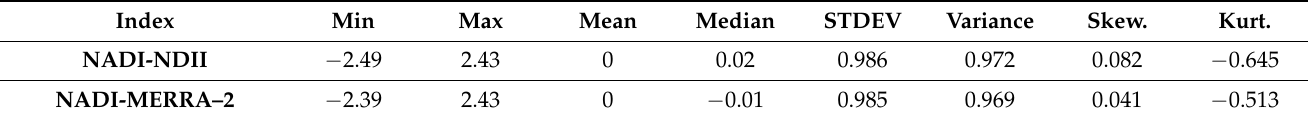
Table 2. Summary statistics of NADI-NDII and NADI-MERRA–2.